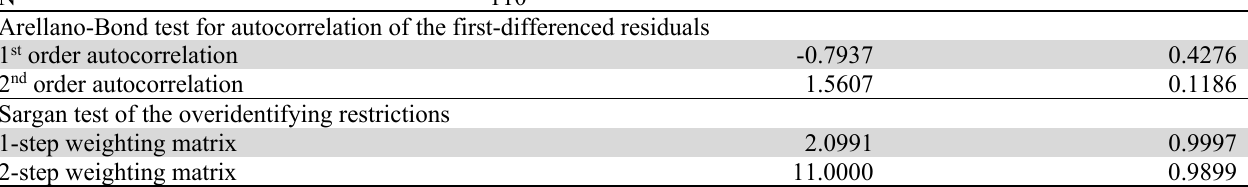
Note: *, ** and *** indicate significance at the 10%, 5%, and 1% level,